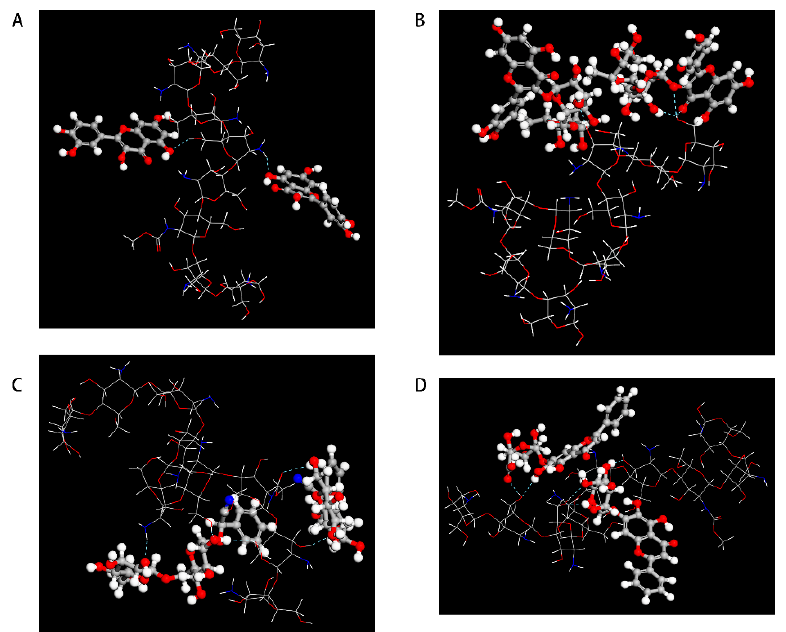
Figure 6. Materials Studio patterns with chitosan of ( A ) quercetin; ( B ) rutinum; ( C ) amygdalin; ( D ) baicalin.